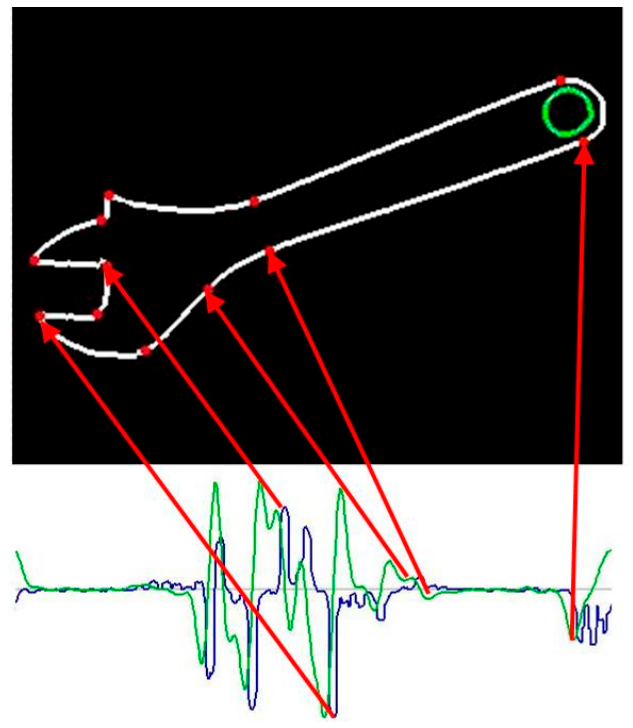
Figure 5. Sample feature points extraction based on signature analysis.